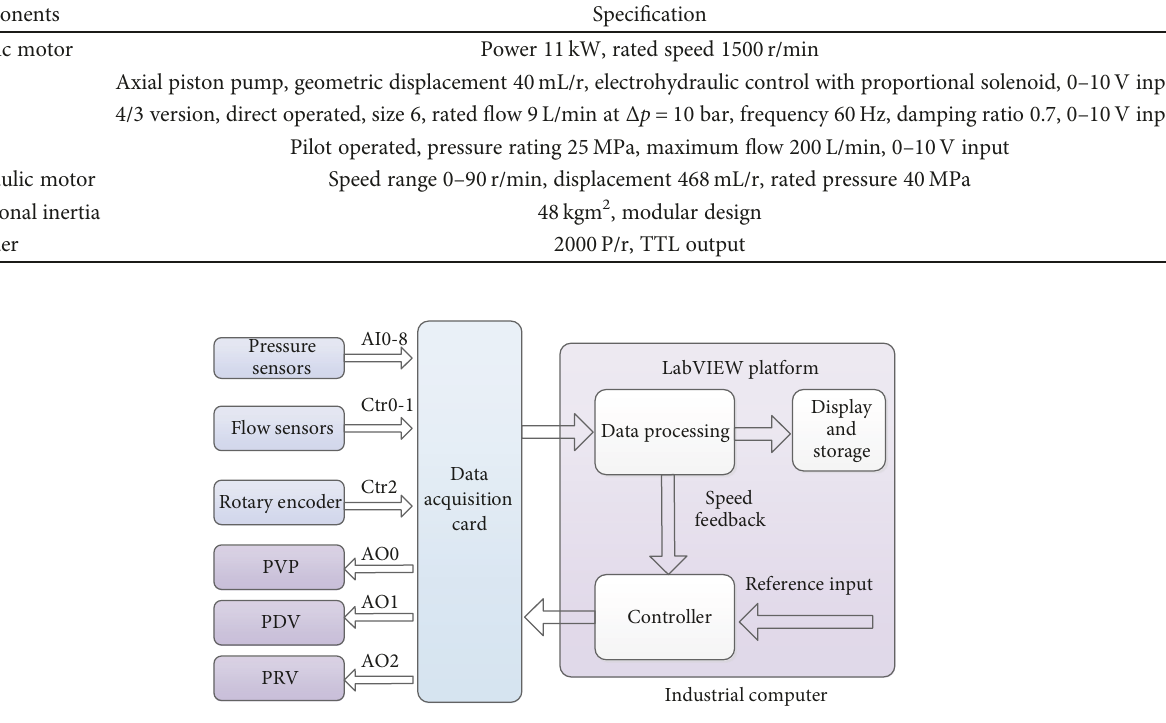
Figure 7: Measurement and control